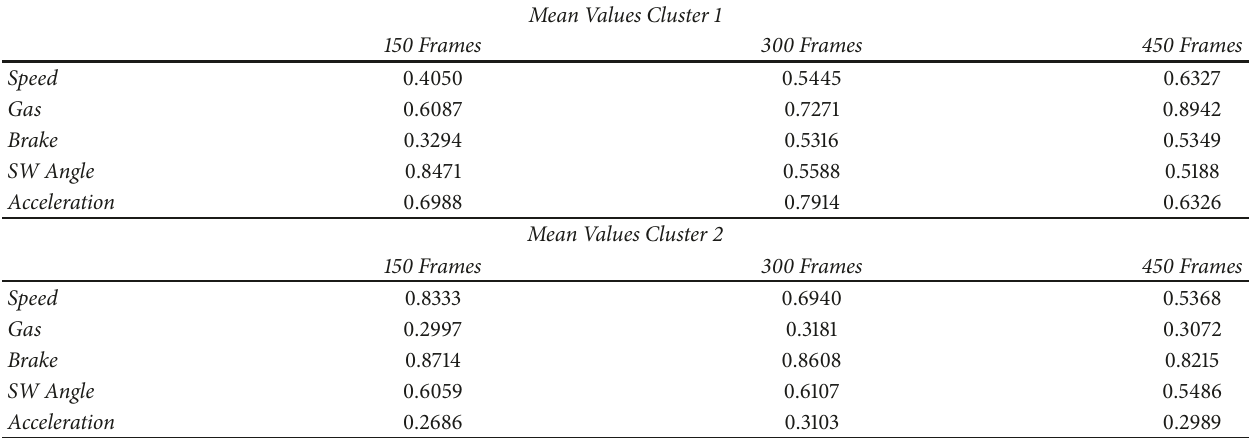
Figure 4: Dendrograms from HCA, from top to bottom, for 150, 300, and 450 frames with driver identification numbers as per Table 1. Table 2: Mean values across frames and